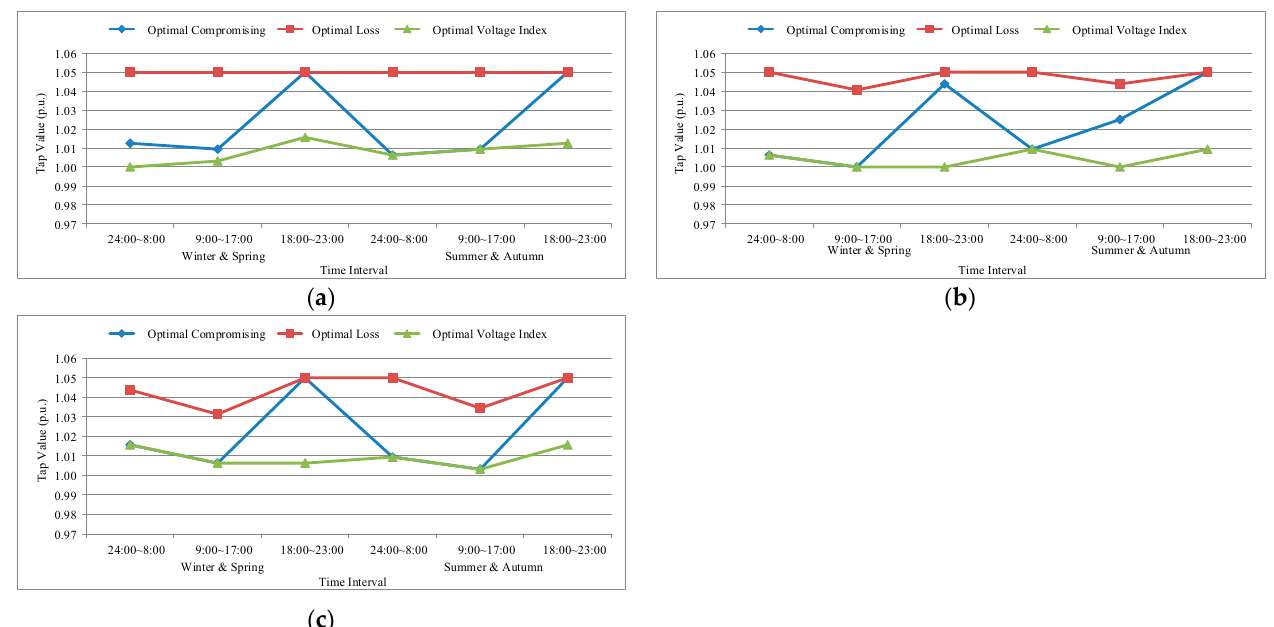
( c ) Figure 13. Tap values for different objectives of the Feeder2-Based simulation. ( a ) PV installed ca- pacity 1000 kW; ( b ) PV installed capacity 3000 kW; ( c ) PV installed capacity 5000 kW. Table 6. The comparison of optimal multi-objective values between the different models. 1000 kW 3000 kW 5000 kW PV Capacity VolQ (p.u.) Loss (kWh) VolQ (p.u.) Loss (kWh) VolQ (p.u.) Model